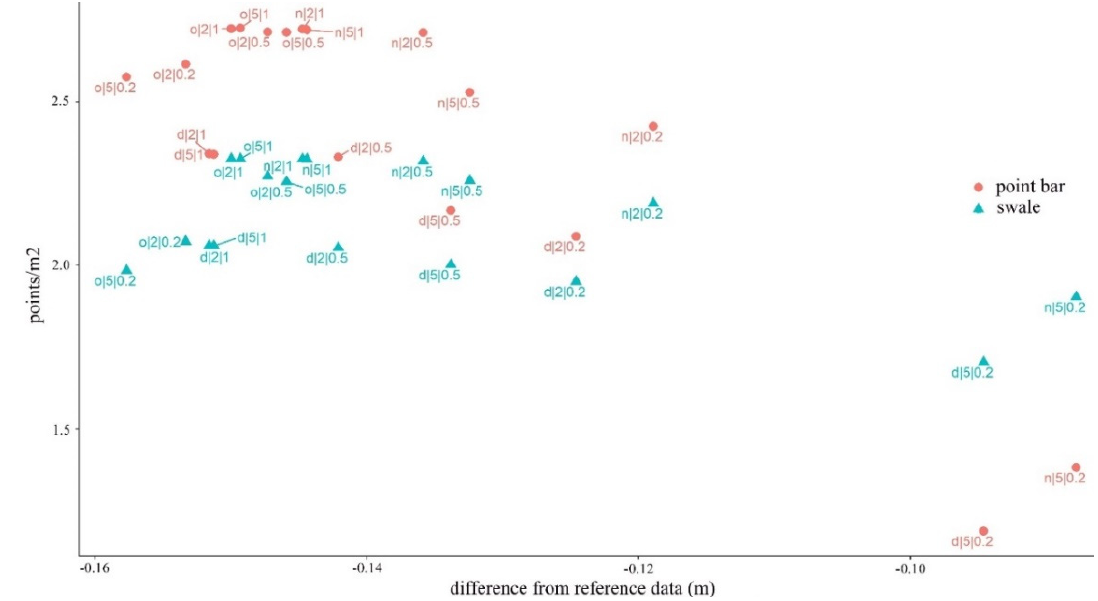
Figure 10. The effect of the noise reduction and the ground point classification on the point bars and swales.